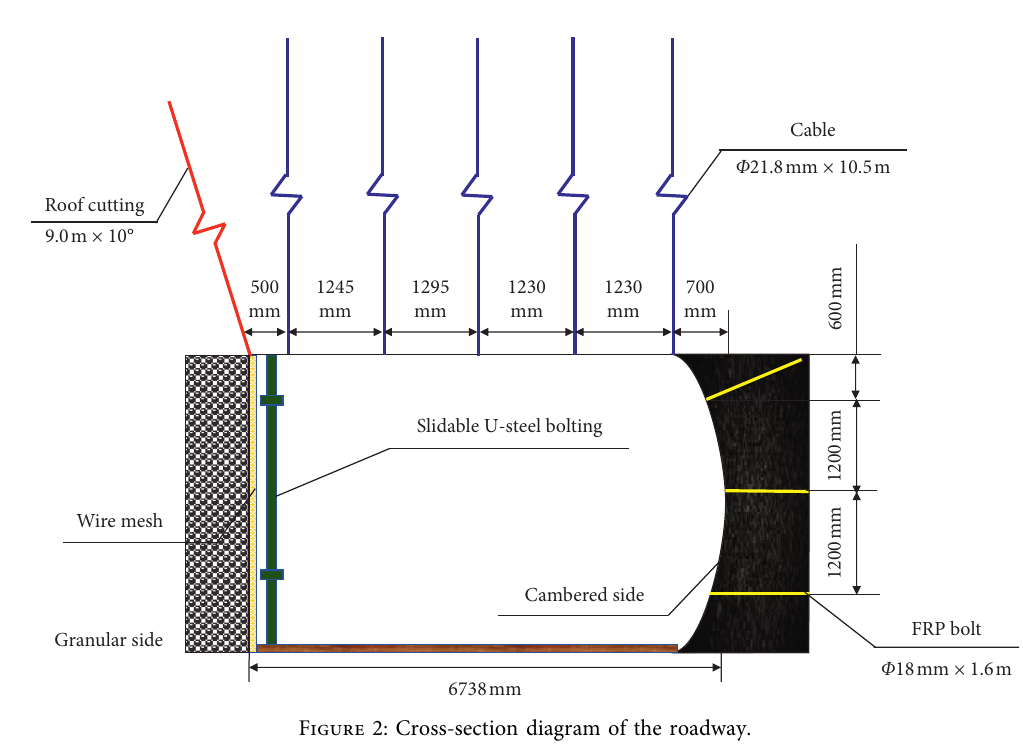
Figure 2: Cross-section diagram of the roadway.